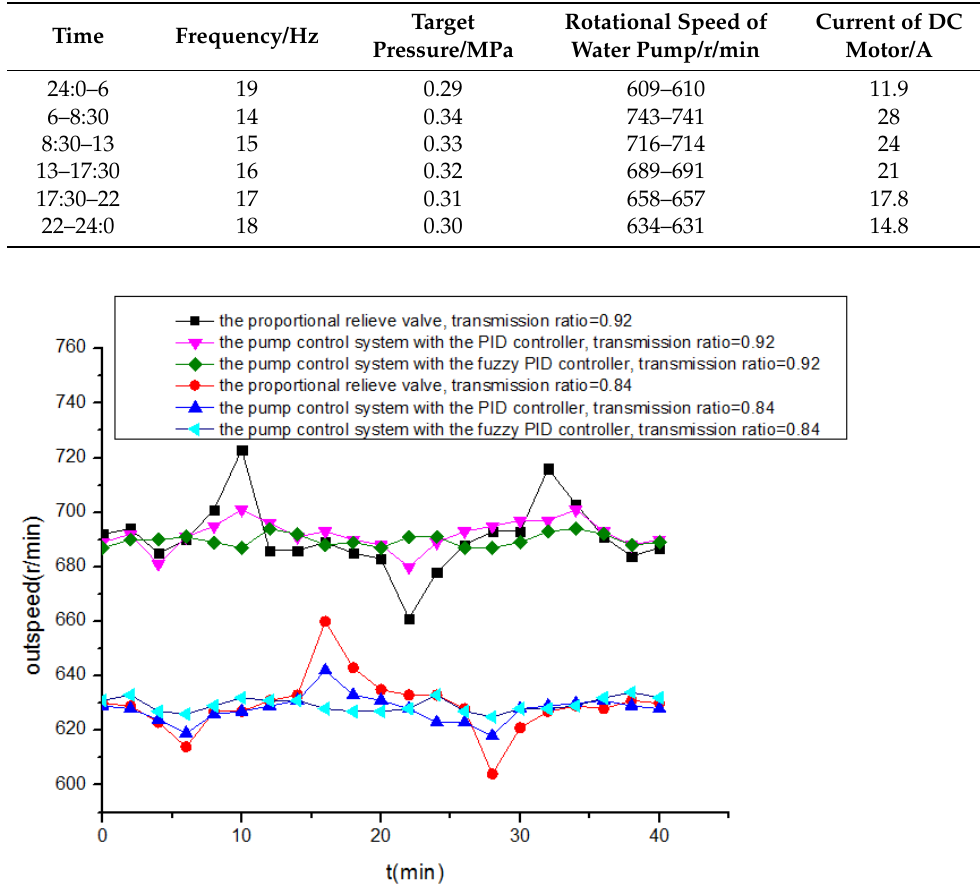
Table 3. Energy saving effect of HVC during the test.